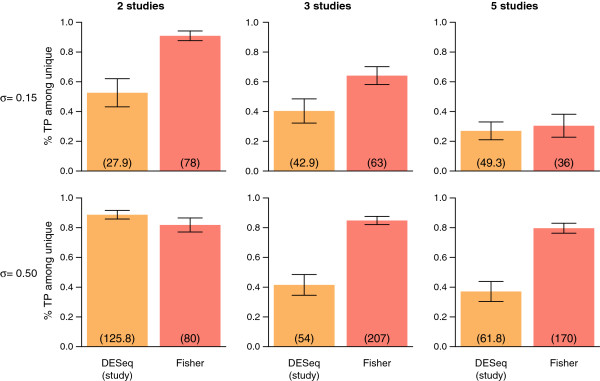
Proportion of true positives among unique discoveries. Proportion of true positives among unique discoveries for DESeq with a fixed study effect (orange bars) and Fisher (red bars). Each barplot represents the results of a particular setting, with columns corresponding (from left to right) to simulations including 2 studies, 3 studies, and 5 studies, and rows corresponding (from top to bottom) to simulations with inter-study variability set to σ = 0.15 and σ = 0.50 (low inter-study variability to large inter-study variability). Error bars represent one standard deviation, and numbers in parentheses represent the mean total number of unique discoveries for DESeq with study effect as compared to Fisher and vice versa, respectively.